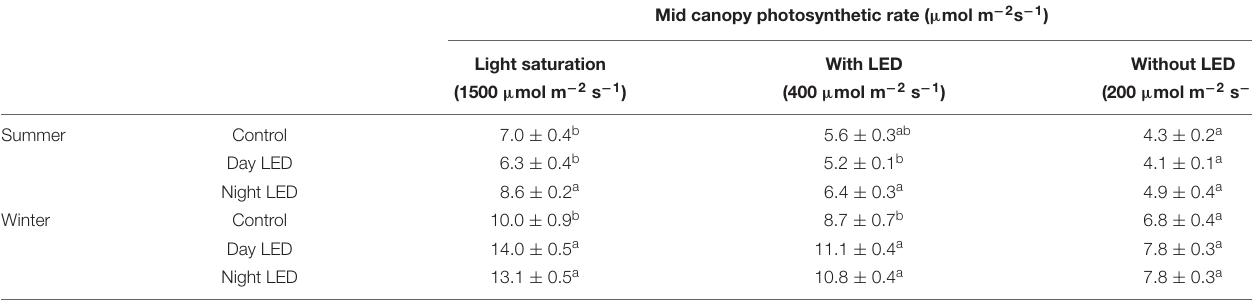
TABLE 1 | Effect of LED inter-lighting on leaf photosynthetic rate of single-truss tomato plants.